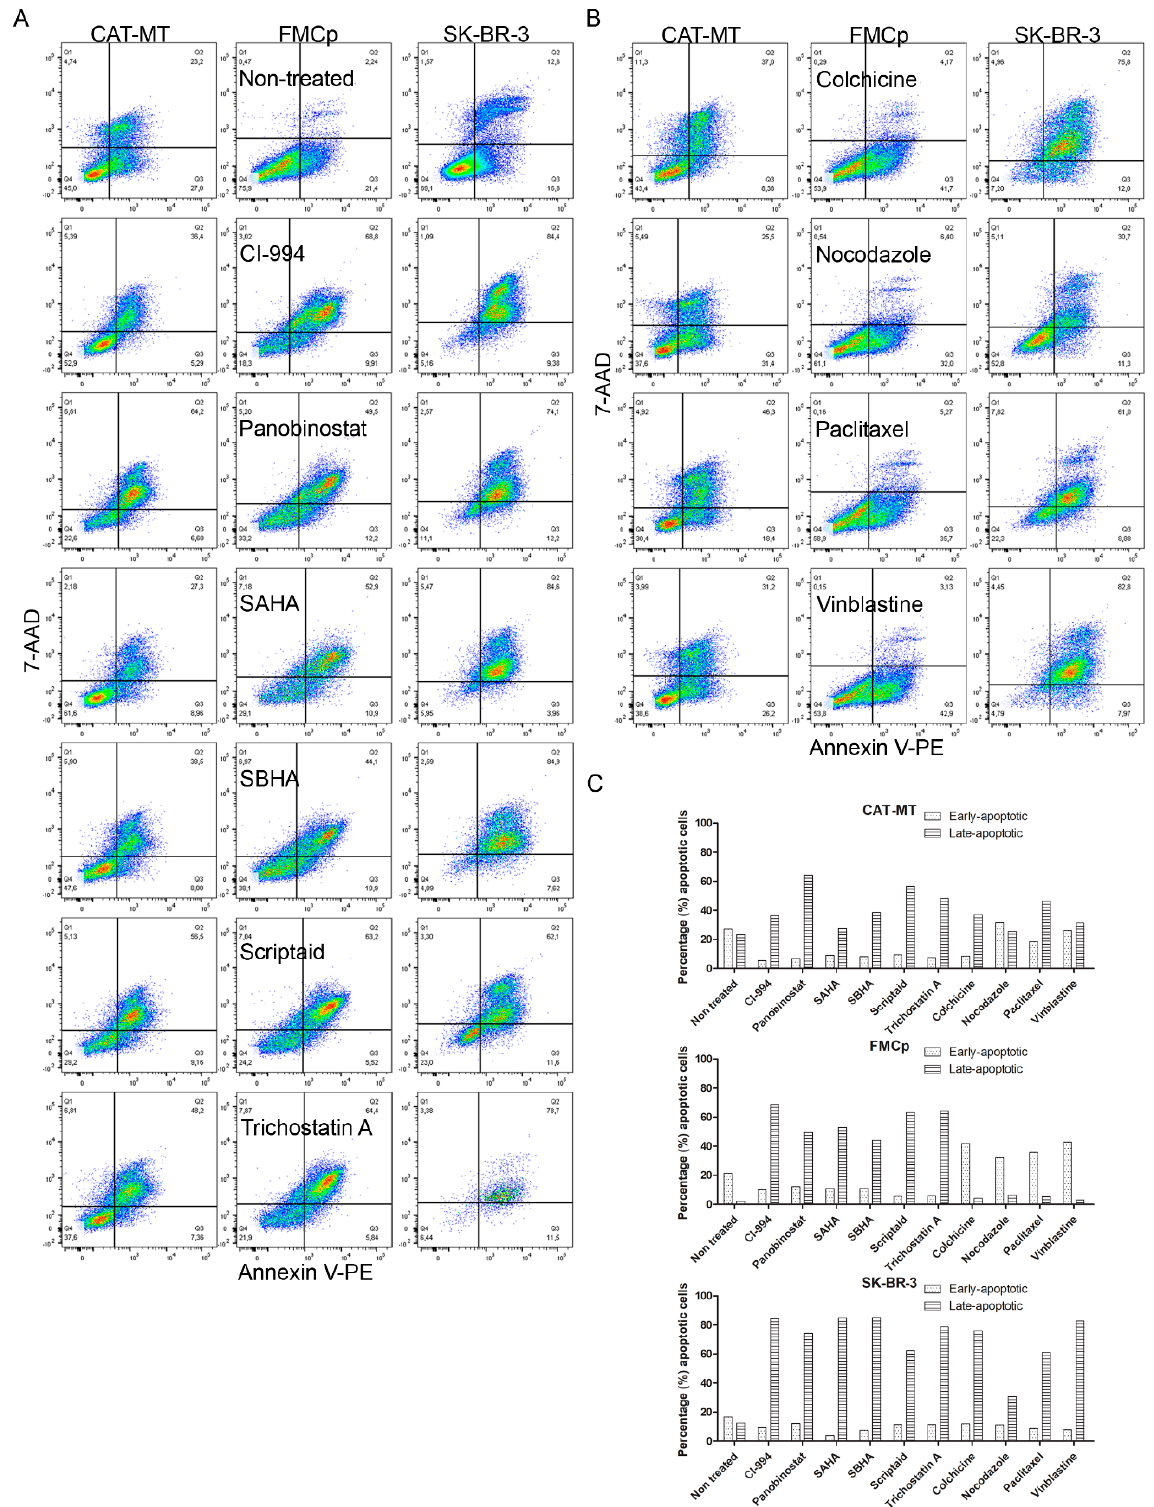
Figure 4. HDACis and MTIs induce apoptosis in feline cell lines. CAT-MT, FMCp, and SK-BR-3 cell lines were incubated with the correspondent IC50 of each HDACi ( A ) or MTI ( B ) for 72 h (for panobinostat and trichostatin A in the FMCp cell line and for paclitaxel in the SK-BR-3 cell line, the IC50 values used were the ones obtained for CAT-MT). Cells were collected, stained with Guava Nexin, and subjected to flow cytometry. ( C ) The percentage of apoptotic cells was determined according to Annexin V/7-AAD staining.